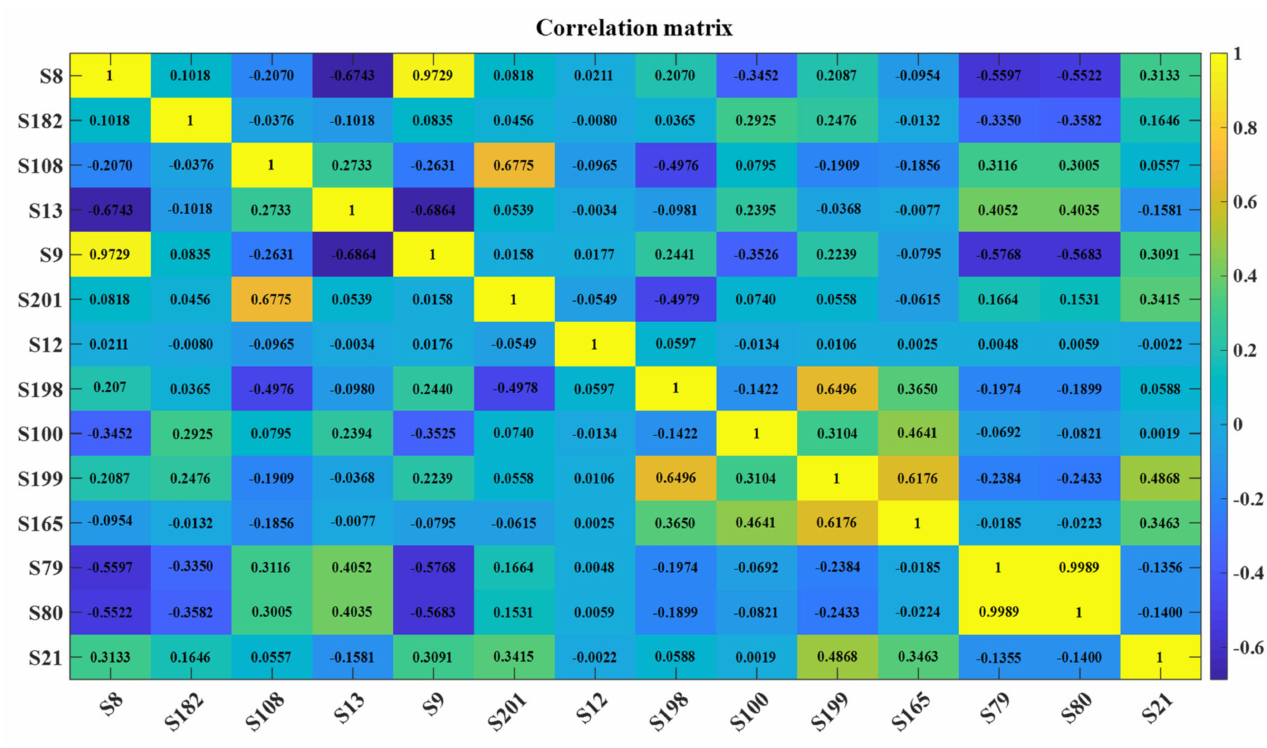
Figure 7. The correlation matrix of the